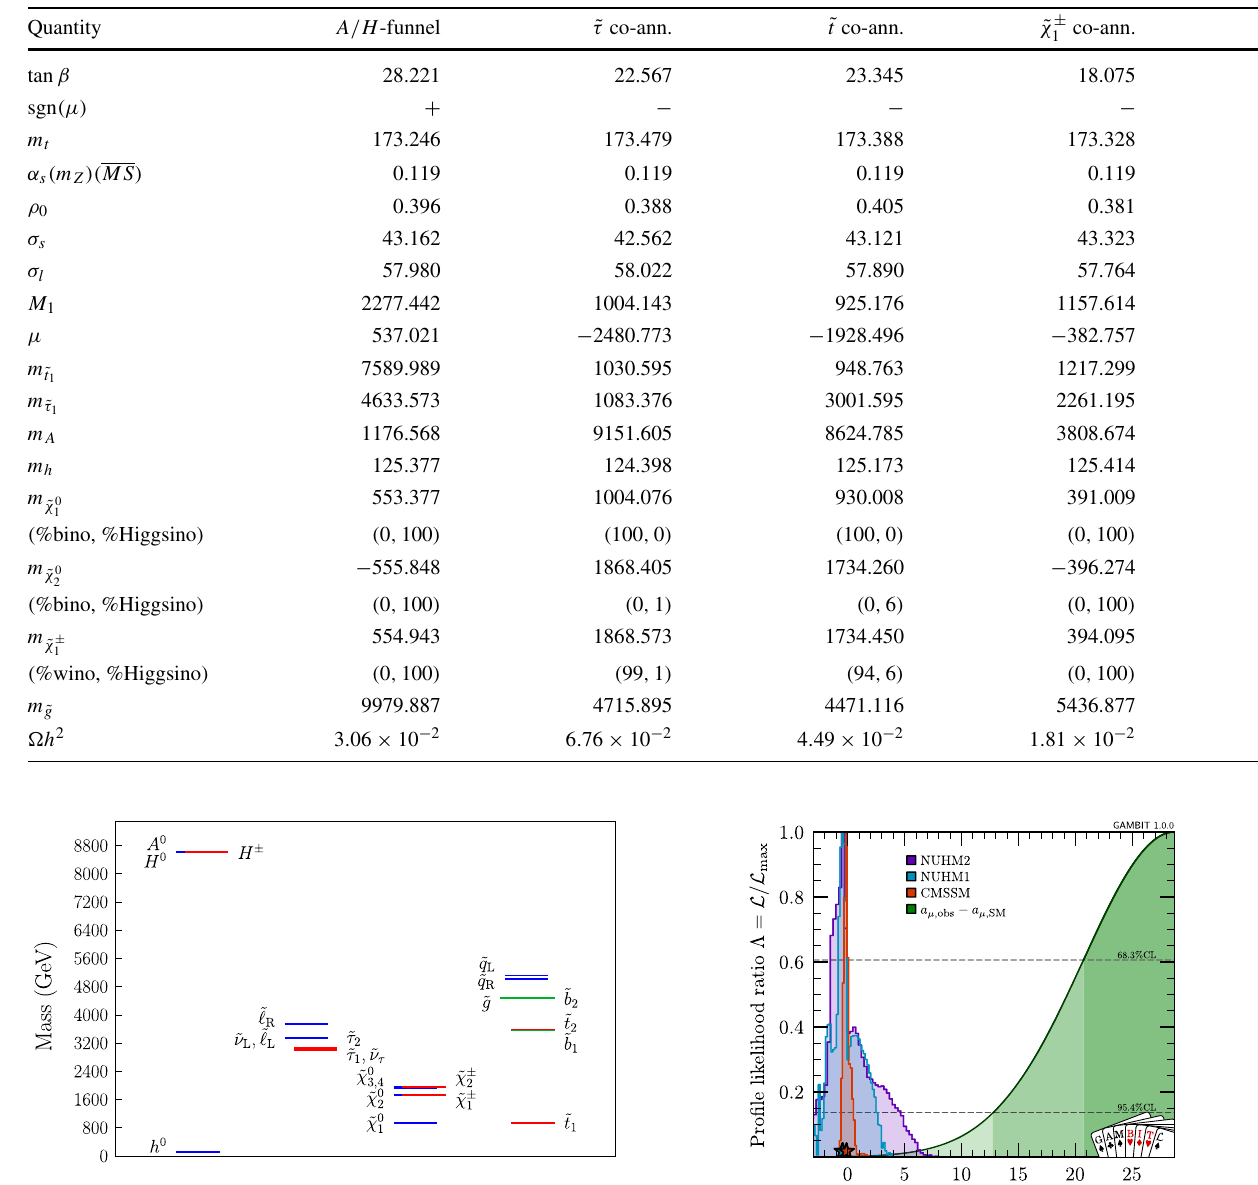
Fig. 10 Sparticle mass spectrum of the NUHM2 best-fit point